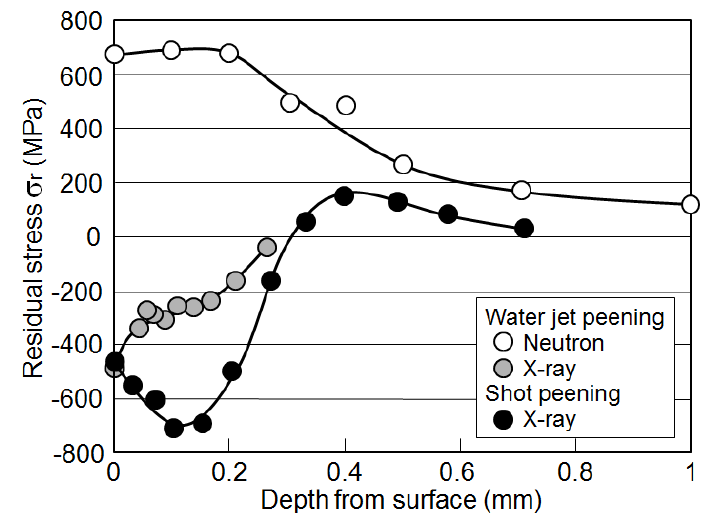
Figure 10. Comparison of residual stress distributions.